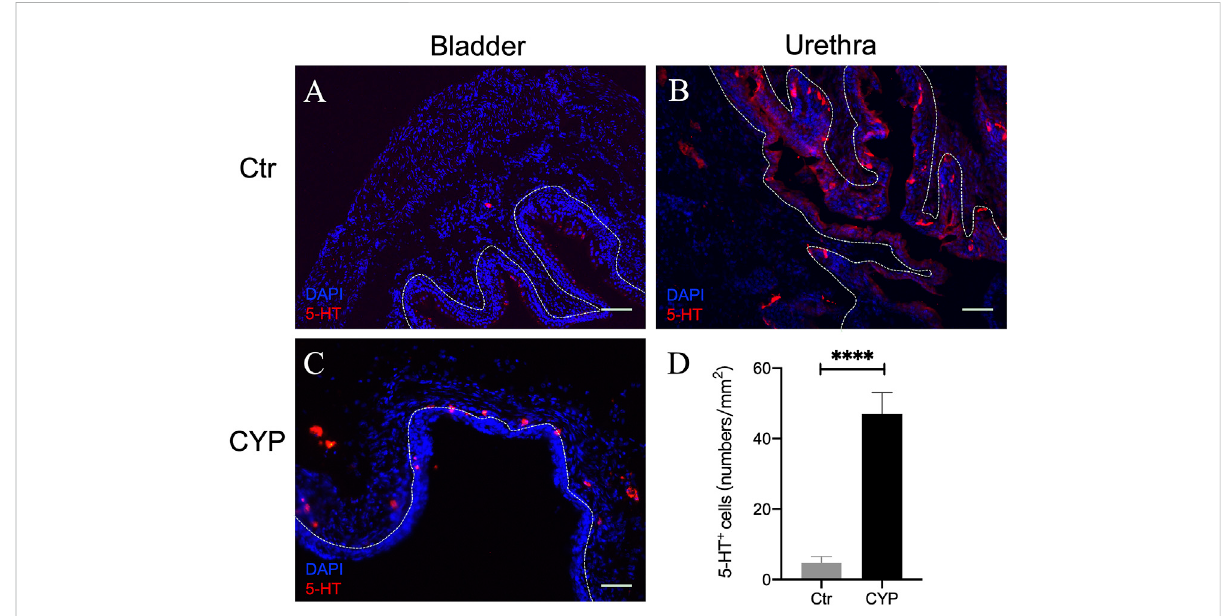
FIGURE 2 5-HT immuno fl uorescence in murine bladder and urethra. (A,B) show representative 5-HT immuno fl uorescence (red) in murine bladder and urethra in the control mice, respectively. Note numerous 5-HT immunoreactive neuroendocrine cells were present in urethral but not bladder urothelium. Very few numbers of 5-HT-ir cells (likely mast cells) were encountered in subepithelium in normal bladder. (C) Immuno fl uorescence of 5-HT in the bladder of CYP-treated mice. (D) Quantitative analysis of 5-HT positive cells in control and CYP-treated mice. (Unpaired t test, n